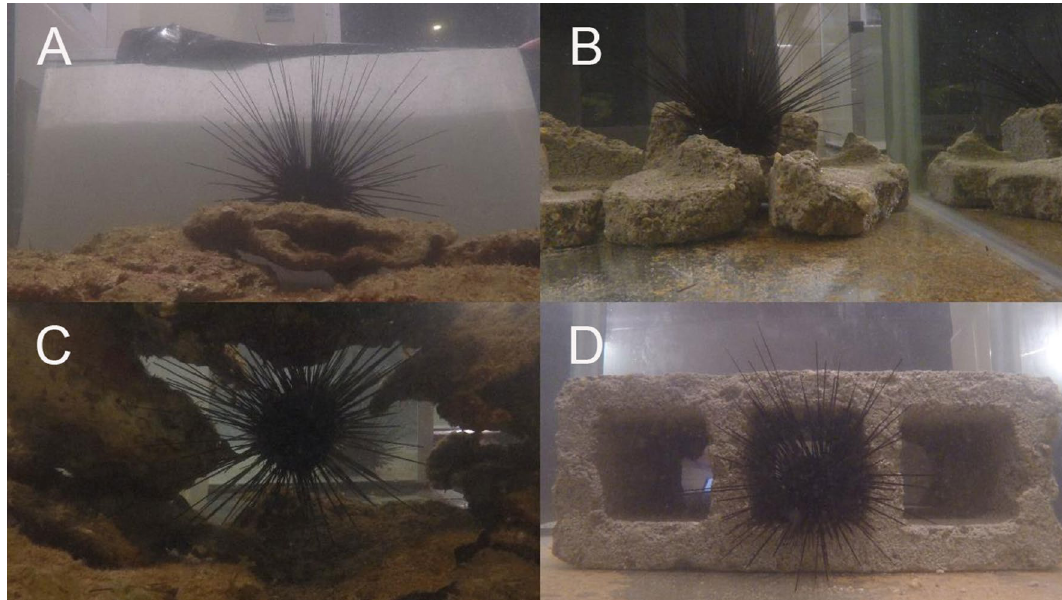
Figure 1. Panel photograph showing tank setup for different complexity treatments. Top left natural-material- low-complexity, top right = artificial-material-low-complexity, bottom left = natural-material-high-complexity, bottom right =